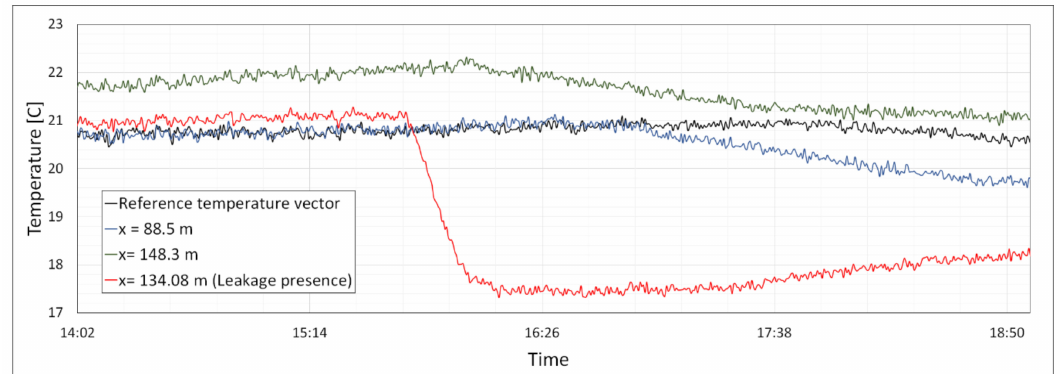
Figure 8. Singularity detection using short-term experimental measurement: Measuring point at x = 134.08 m corresponding to the location of a leakage path is the singularity that shows a di ff erent trend of temperature variation compared with the non-singularity